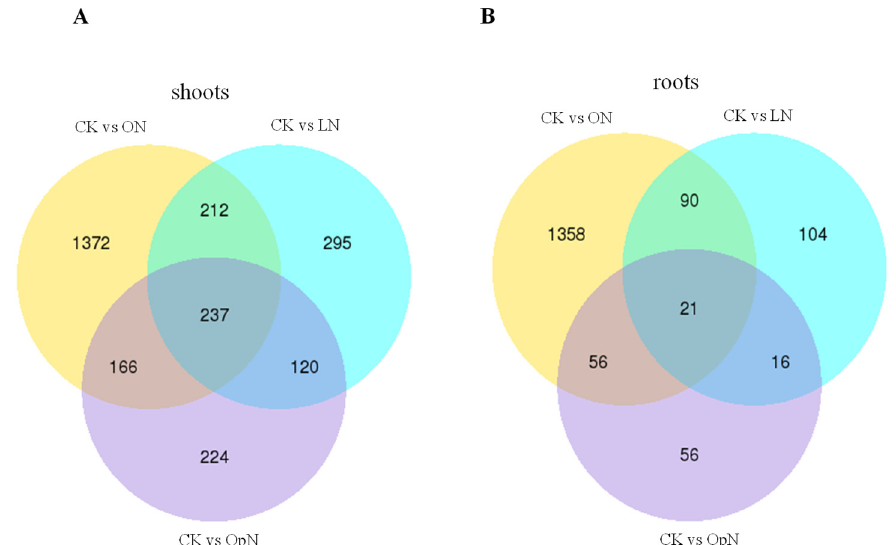
Figure 2. Venn diagrams showing the number of unique and overlapping DEGs for each comparison between N treatments. Compared with the control, the three N treatments shared 237 and 21 DEGs in shoots ( A ) and in roots ( B ), respectively.